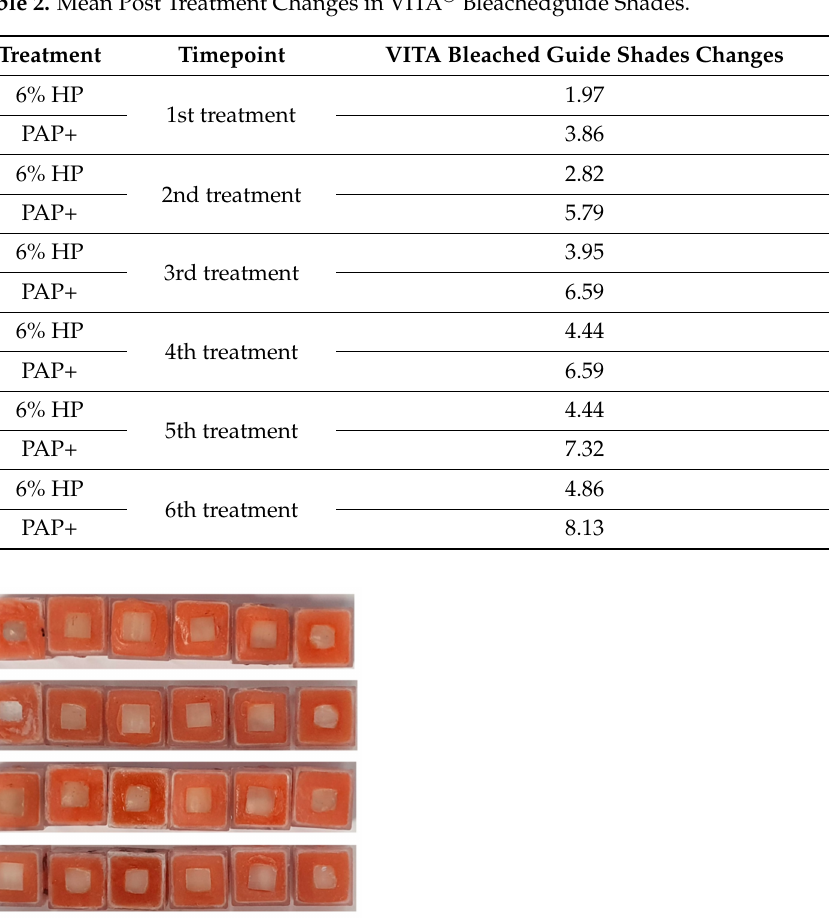
Figure 4. ( a , c ) Pre-treatment enamel discs; ( b ) 6% HP post-treatment enamel discs; ( d ) PAP+ post- treatment enamel discs. The images are intended for illustration purposes